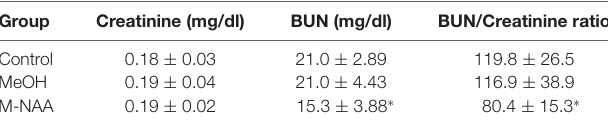
TABLE 1 | Activities of toxicity markers in serum. Group